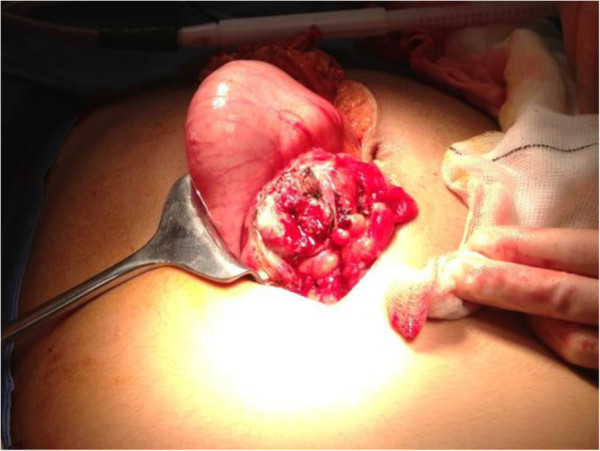
Postsplenectomy.